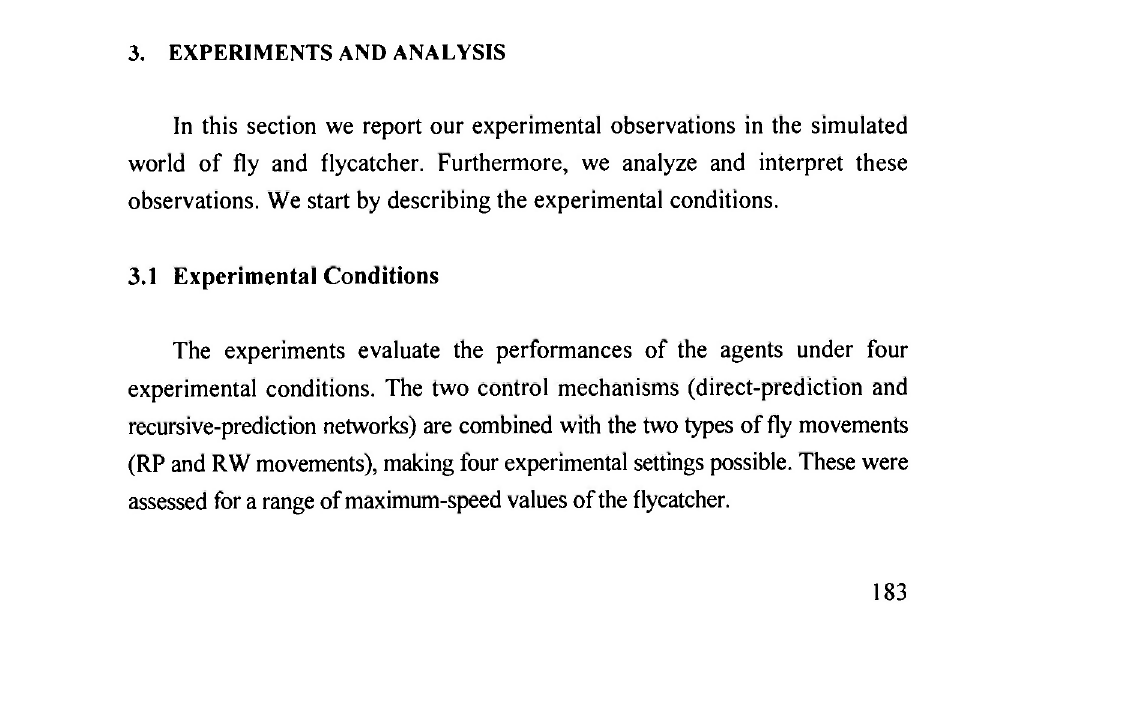
Fig. 5: The prediction mechanism of recursive-prediction networks.